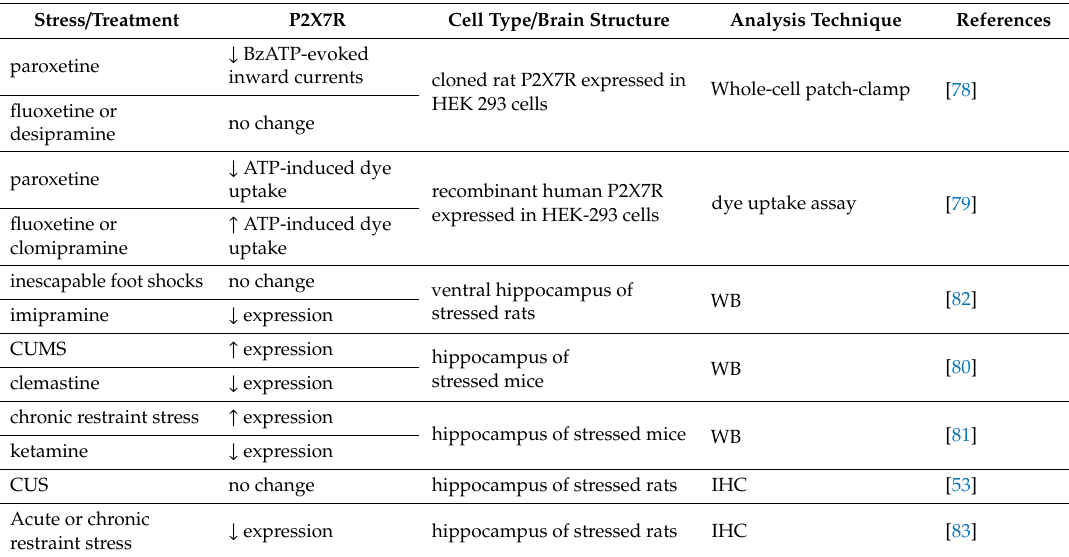
Table 1. P2X7R modulation by stress and antidepressant